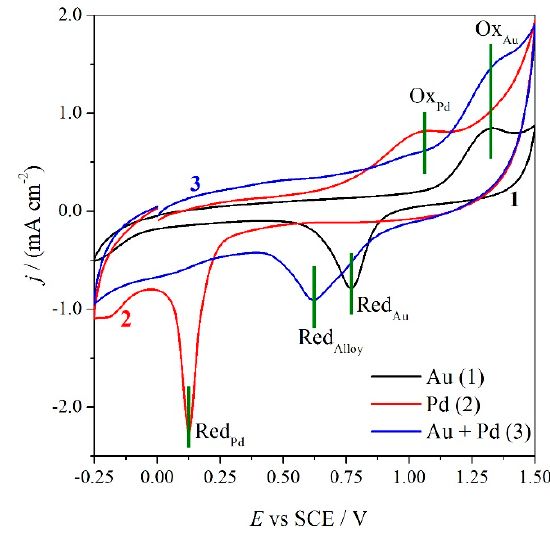
Figure 3. Cyclic Voltammetry of GC electrode modified with AuNP (1), PdNP (2) and Au-Pd alloy (3), registered in 0.1 M sulphuric acid at a sweep rate of 0.5 V·s − 1 .